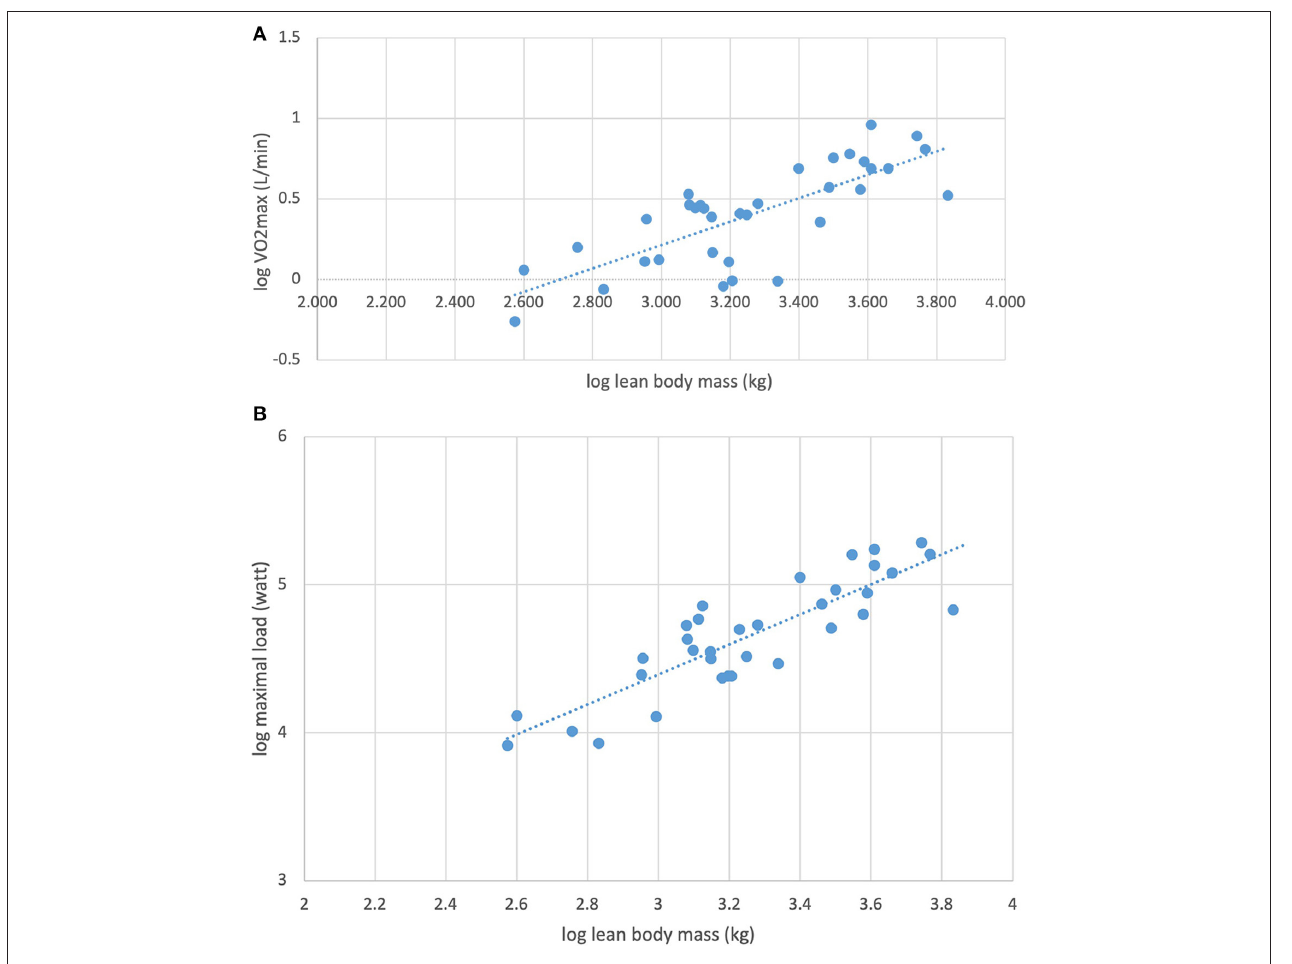
FIGURE 1 | (A) Association between log transformed maximal oxygen consumption (VO 2max ) and log transformed lean body mass in 34 kidney transplanted children ( R 2 = 0.59, β = 0.73, p < 0.0001). (B) Association between log transformed maximal load (watt) and log transformed lean body mass in 34 kidney transplanted children ( R 2 = 0.75, β = 1.02, p <